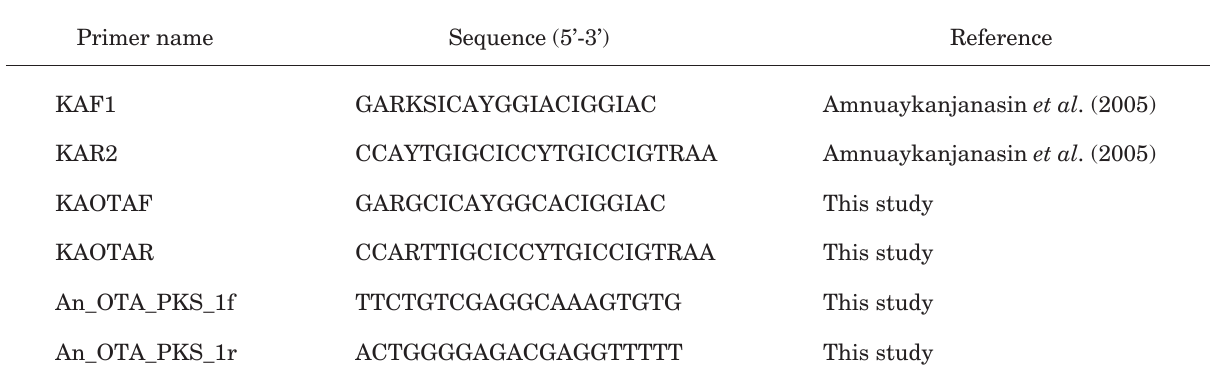
Table 1. Primers used in this